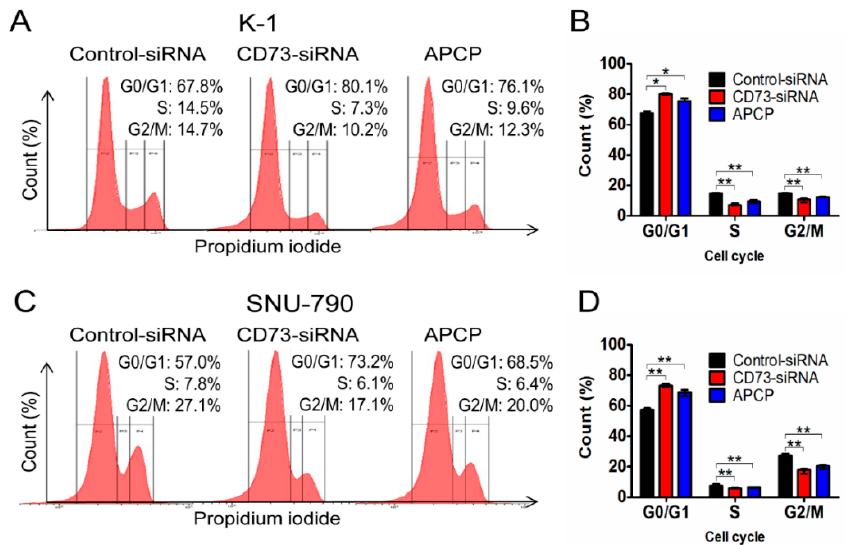
Figure 5. Analysis of cell cycle progression in PTC cell lines by flow cytometry. Downregulation of CD73 arrests cell cycle progression of K ‐ 1 cells ( A , B ) and SNU ‐ 790 cells ( C , D ). Data are shown as median and interquartile range from five independent experiments ( B , D ). * p < 0.05, ** p < 0.01 determined by Mann–Whitney test.